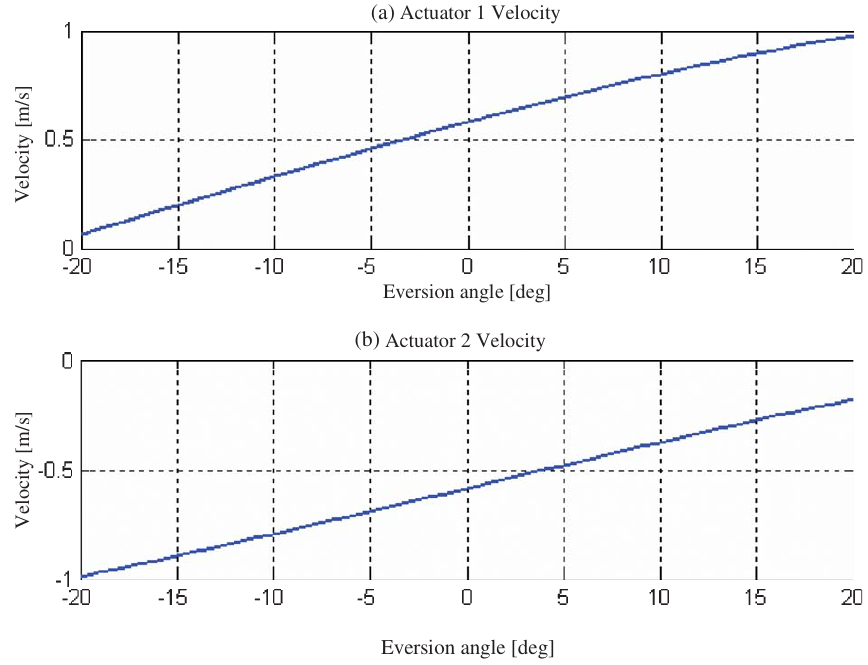
Fig. 14. Actuators velocity in a pure eversion